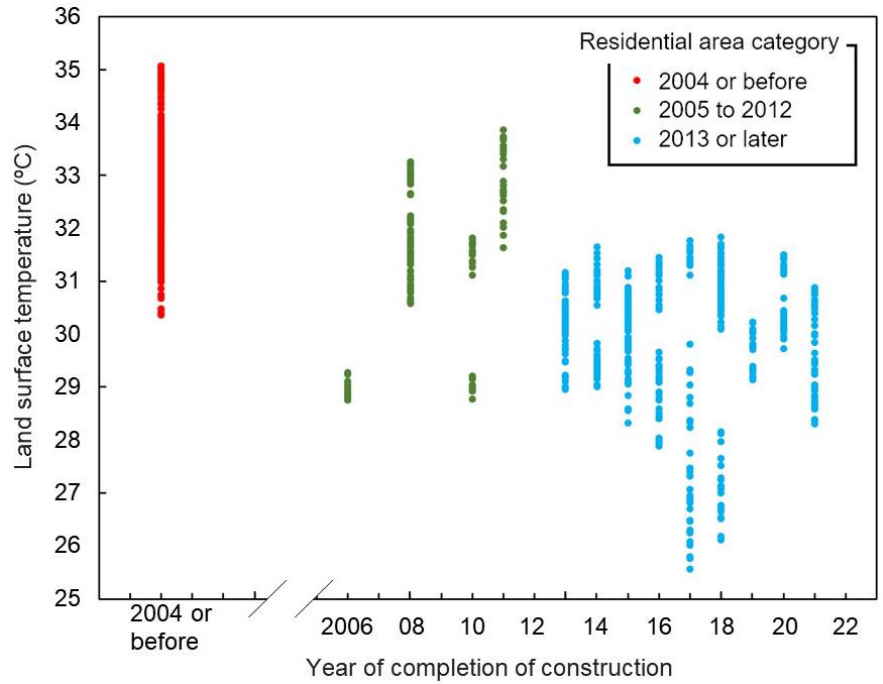
Figure 3. Values of land surface temperature for all pixels representing the residential areas completed in 2021 or earlier in the Bangkok region. For some areas, the precise completion years could not be identified although the areas were completed between 2005 and 2012. For these areas, land surface temperature values are shown as those for the 2008- completed